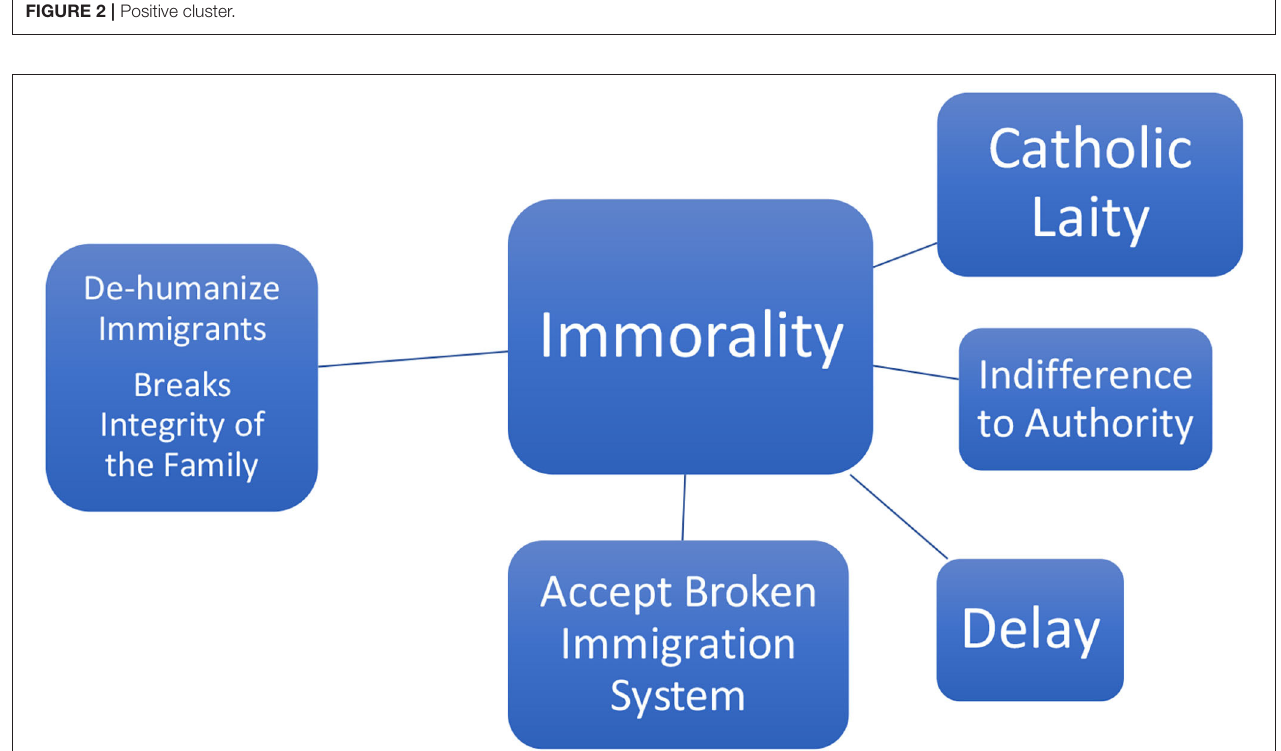
FIGURE 3 | Negative